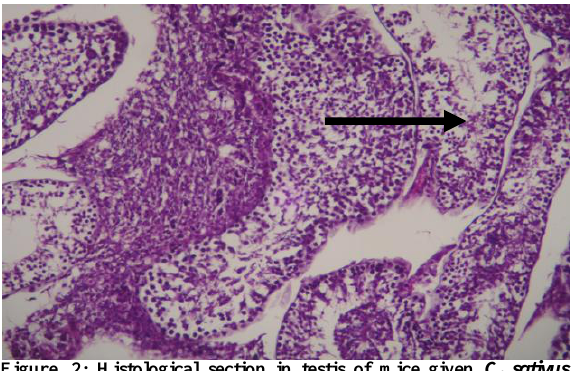
Figure, 2: Histological section in testis of mice given C. sativus aqueous extract shows regeneration of seminiferous tubules and spermatogonia lining (H and E X40).